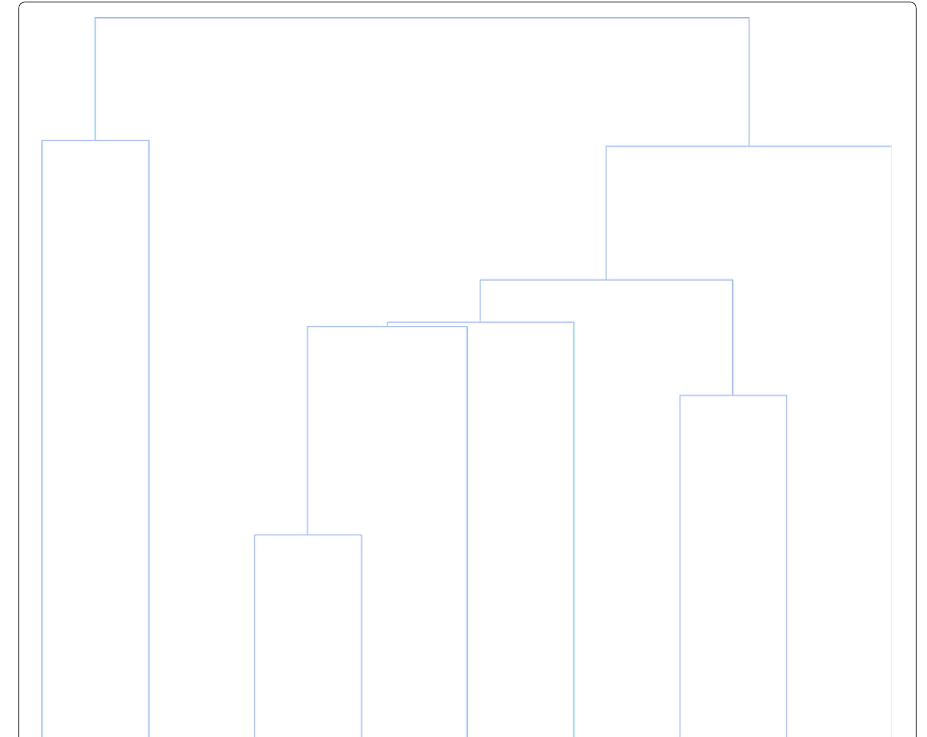
Fig. 3 Dendogram of hierarchical clustering in